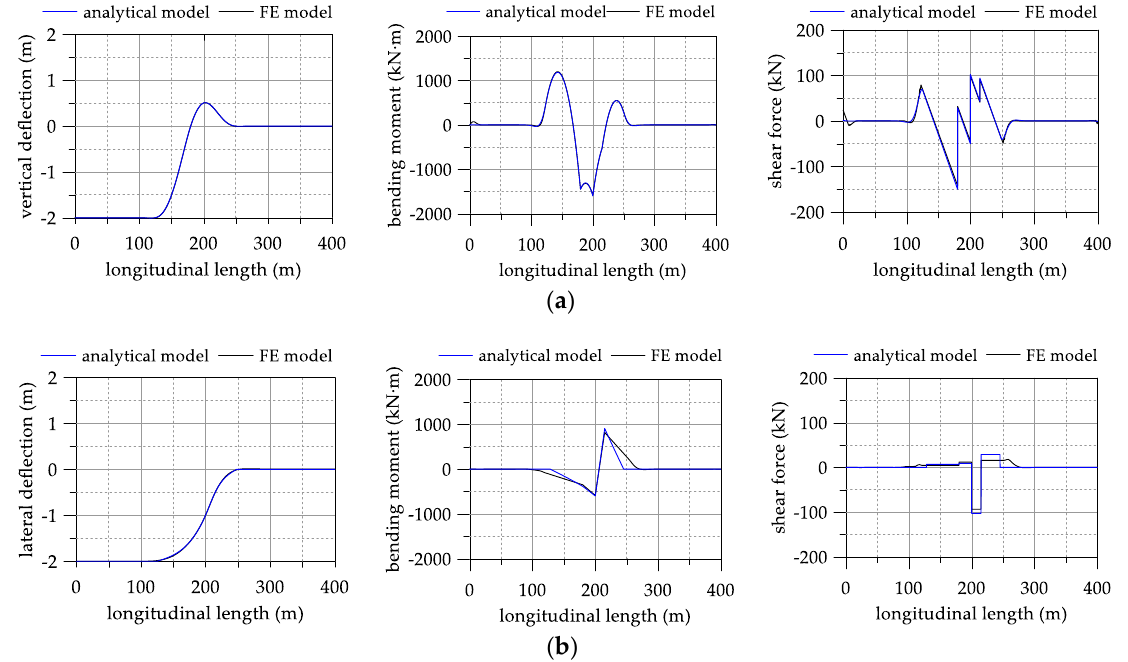
Figure 9. Comparison of Model 2 to FE analysis results during lowering-in: ( a ) vertical plane (x-y plane); ( b ) lateral plane (x-z plane).